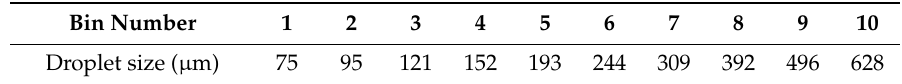
Table 2. Droplet size for each bin used in the study.